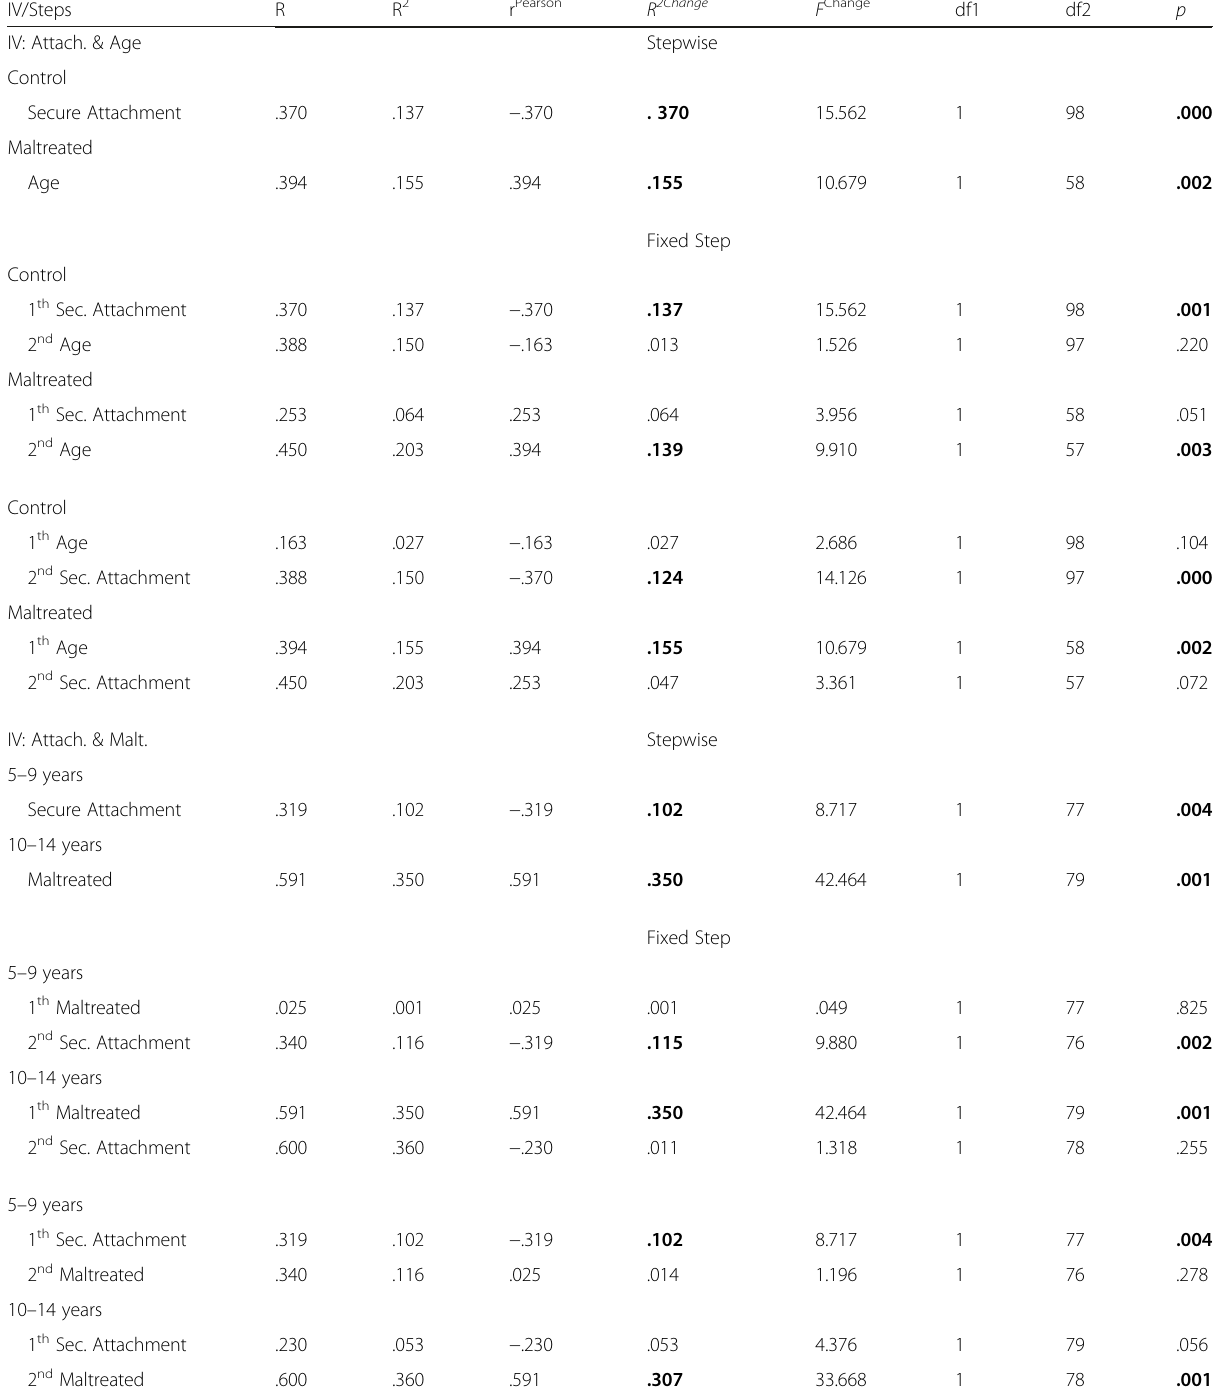
Table 1 Stepwise and fixed step multiple regressions considering as dependent variable Locus of Control